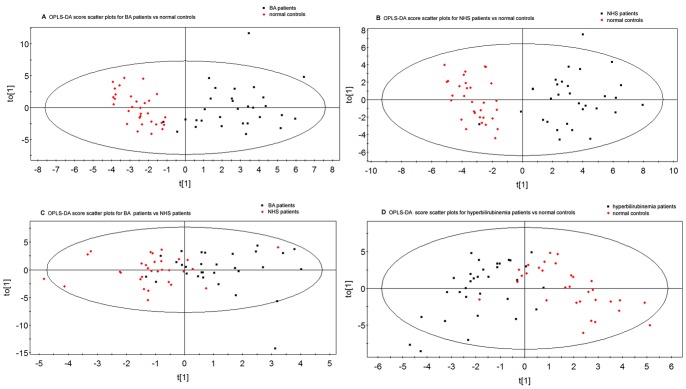
OPLS-DA score scatter plots obtained from of LCMS analysis of samples.A. OPLS-DA score plots of BA and normal; B. OPLS-DA score plots of with NHS and normal; C. OPLS-DA score plots of BA and NHS; D. OPLS-DA score plots of hyperbilirubinemia and normal. The fig. showing that the two populations are well separated respectively.